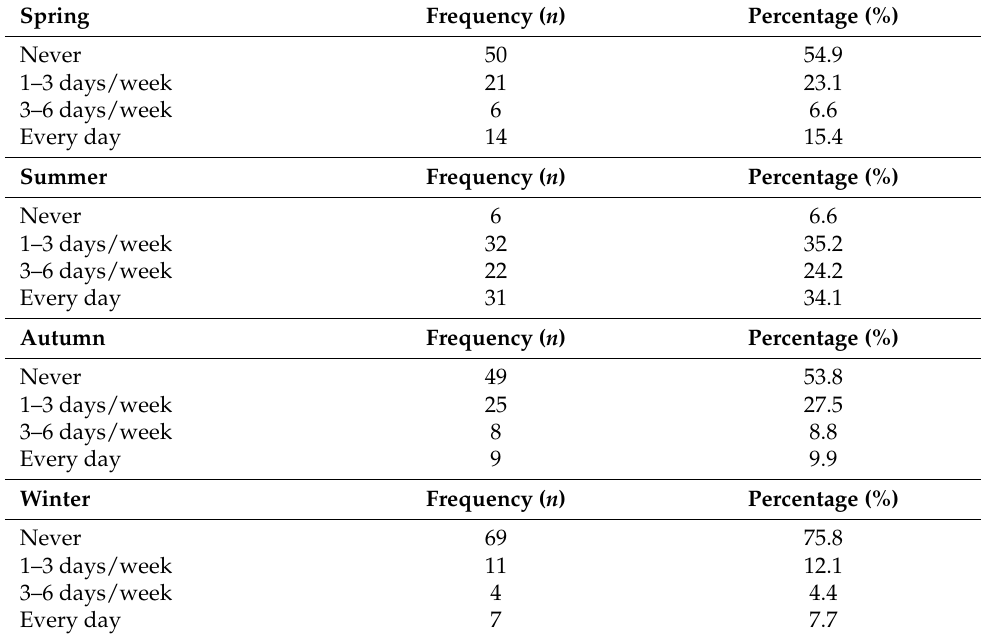
Table 5. Use of sun